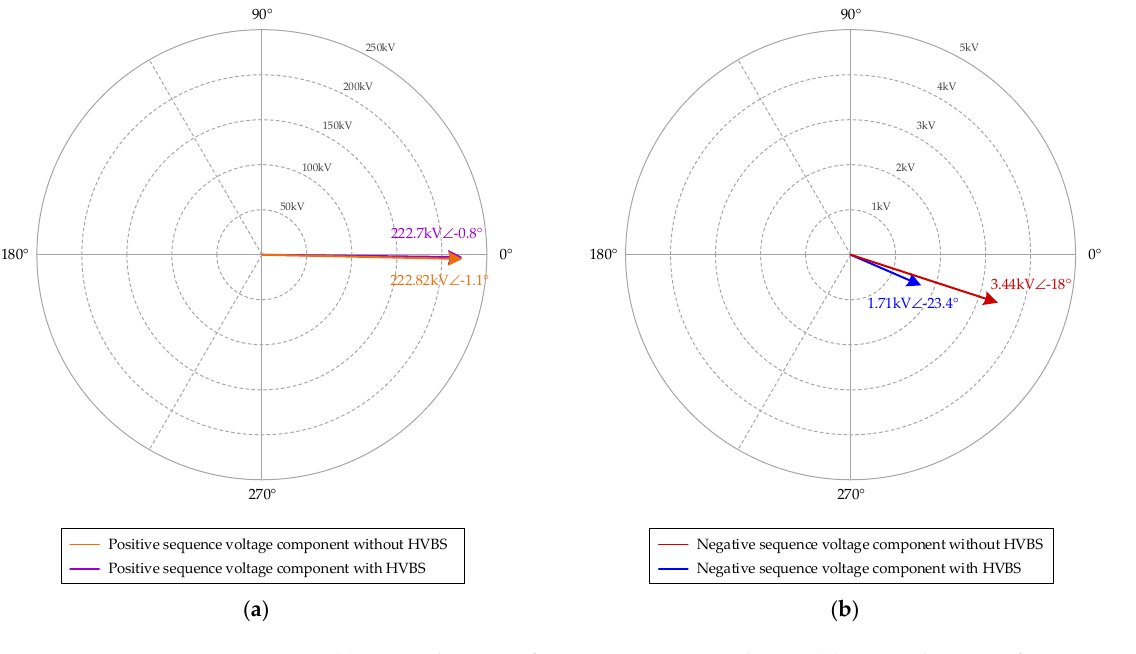
Figure 13. ( a ) Vector diagram of positive-sequence voltages. ( b ) Vector diagram of negative-sequence voltages.